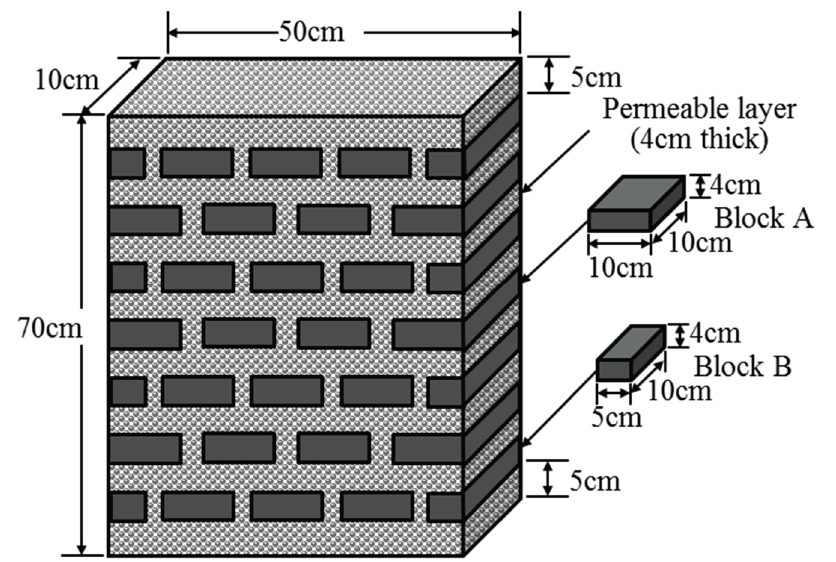
Figure 4. Indoor apparatus for testing the MSL systems.